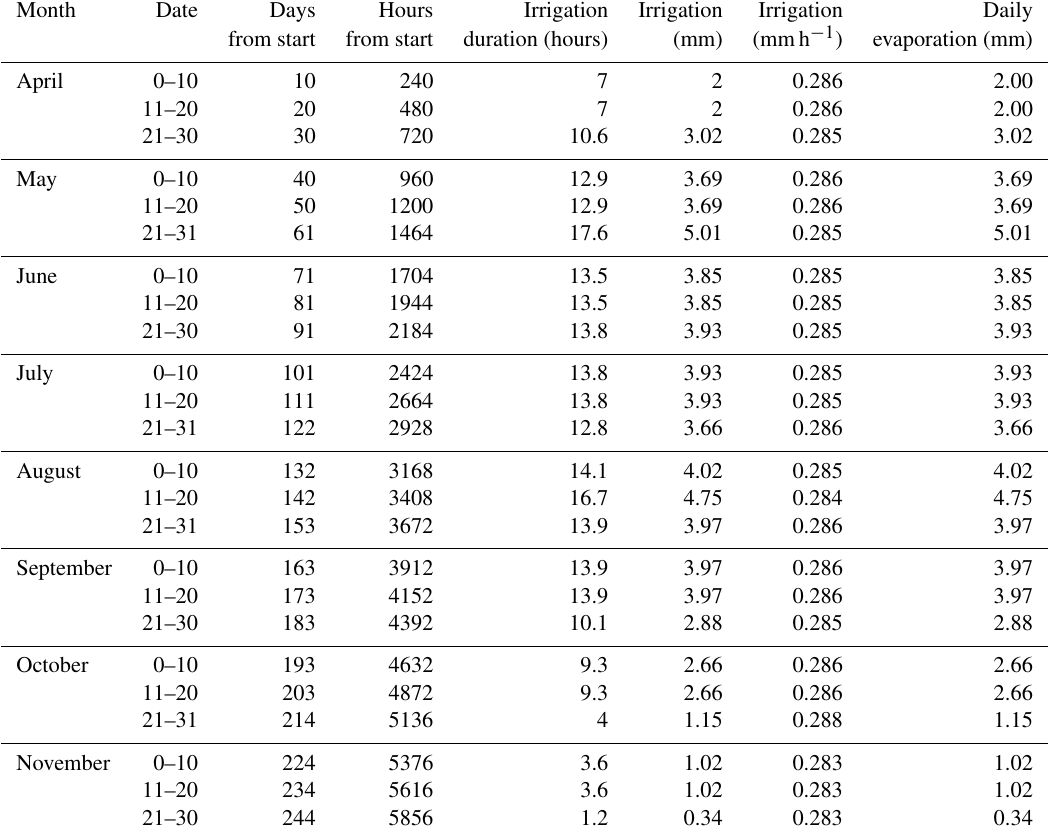
Table 2. Irrigation and evaporation data used in the